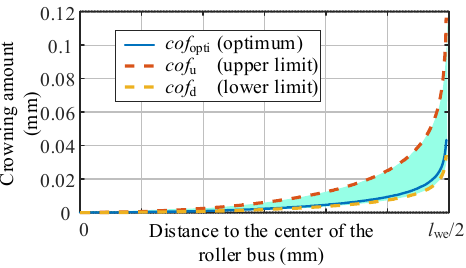
Figure 27. Optimal crowning profile and its tolerance zone of roller of bearing 1. The stress distribution along the profile of the maximum loaded roller before and after being crowned is shown in Figure 28.